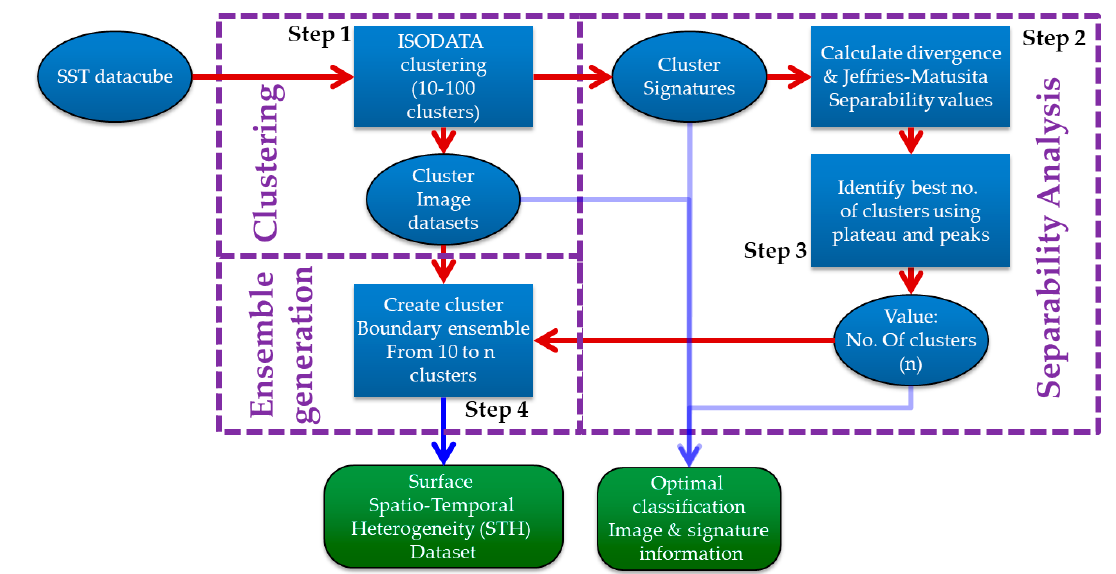
Figure 3. A detailed sub-process flow diagram of the OHMA, with three critical data processing stages highlighted under clustering, separability analysis, and ensemble generation. Outputs of the process are highlighted in green rounded boxes.